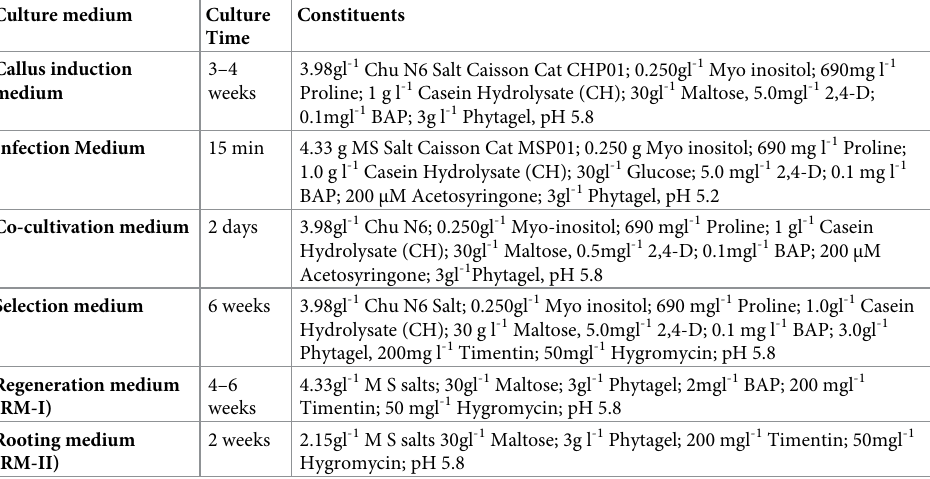
Table 1. Composition of various media used for tissue culture and Agrobacterium -mediated genetic transforma- tion